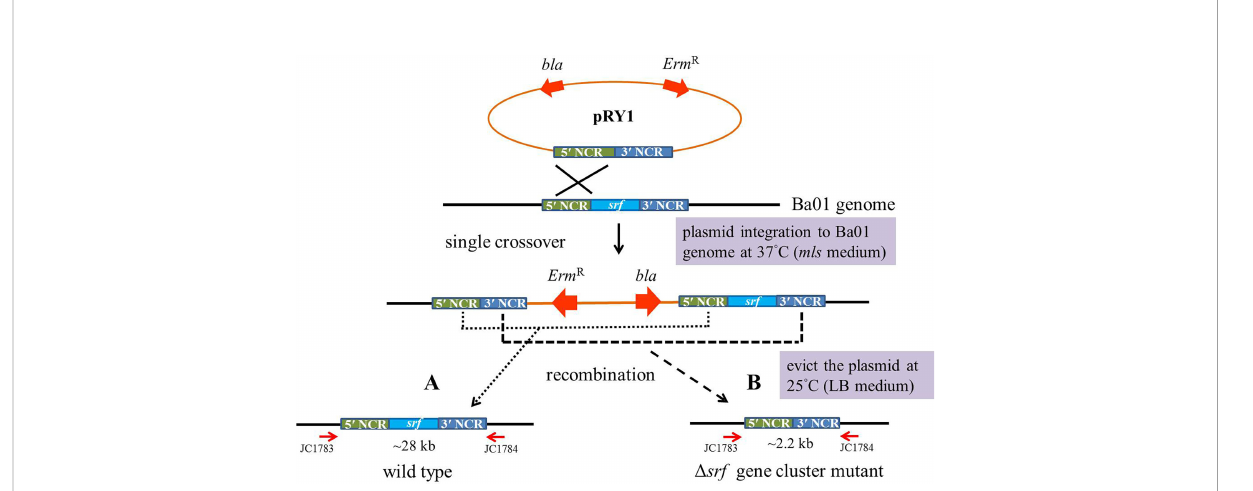
FIGURE 2 Scheme of in-frame markerless deletion method to construct the srf gene cluster mutants in B amyloliquefaciens Ba01. Single crossover recombinants were obtained by culturing the transformants at restrictive temperature (37°C) for plasmid pRY1 integration into Ba01 genome and using mls medium for selection. To evict the plasmid from Ba01 genome after homologous recombination, the strain was incubated overnight in 3 ml of LB broth at a permissive temperature (25°C) for plasmid replication. The cell cultures were diluted and plated on LB agar at 37°C for 24 h The colonies were patched on mls medium to select mls -sensitive colonies. The srf gene cluster mutants were checked by PCR with primers